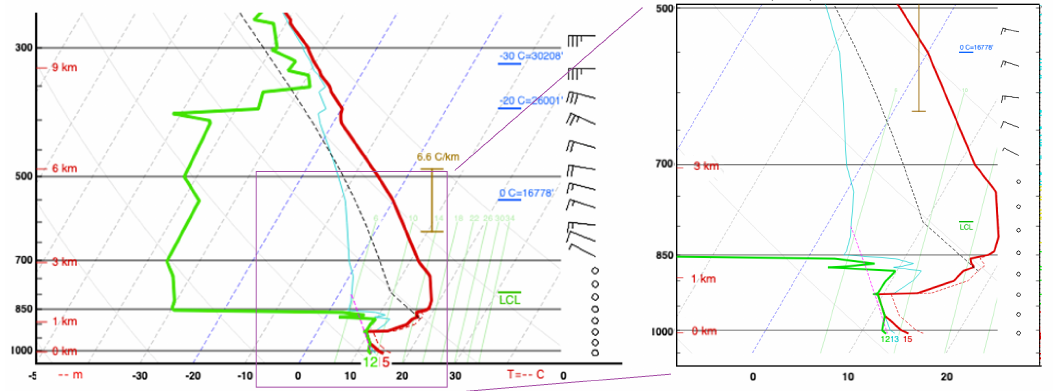
Figure 10. Skew-T log-P (SHARPpy) [22]. Sounding launched from Santo Domingo (120 km south of Papudo) on 20 January 2019 at 12:00 p.m. UTC. The red line is temperature in ◦ C and green line is dew point temperature in ◦ C. Cloud is expected when the two curves intercept. Thus, the cloud layer is estimated from 311 to 663 m (a.m.s.l) capped by a strong inversion layer. Data from Dirección Meteorológica de Chile, https://climatologia.meteochile.gob.cl/application/index/productos/RE5014 (Santo Domingo station code of 330030 at